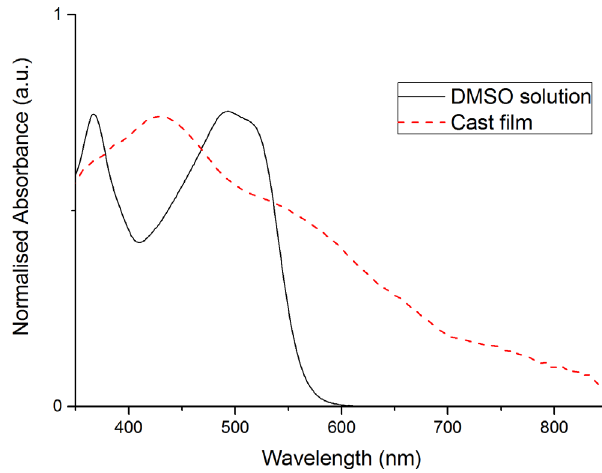
Fig. 1. UV – Vis absorption spectra of RhBT.